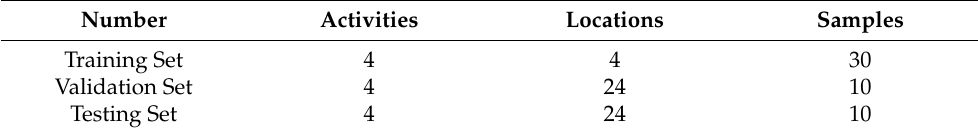
Table 2. Dataset allocation in the location-independent HAR evaluation.